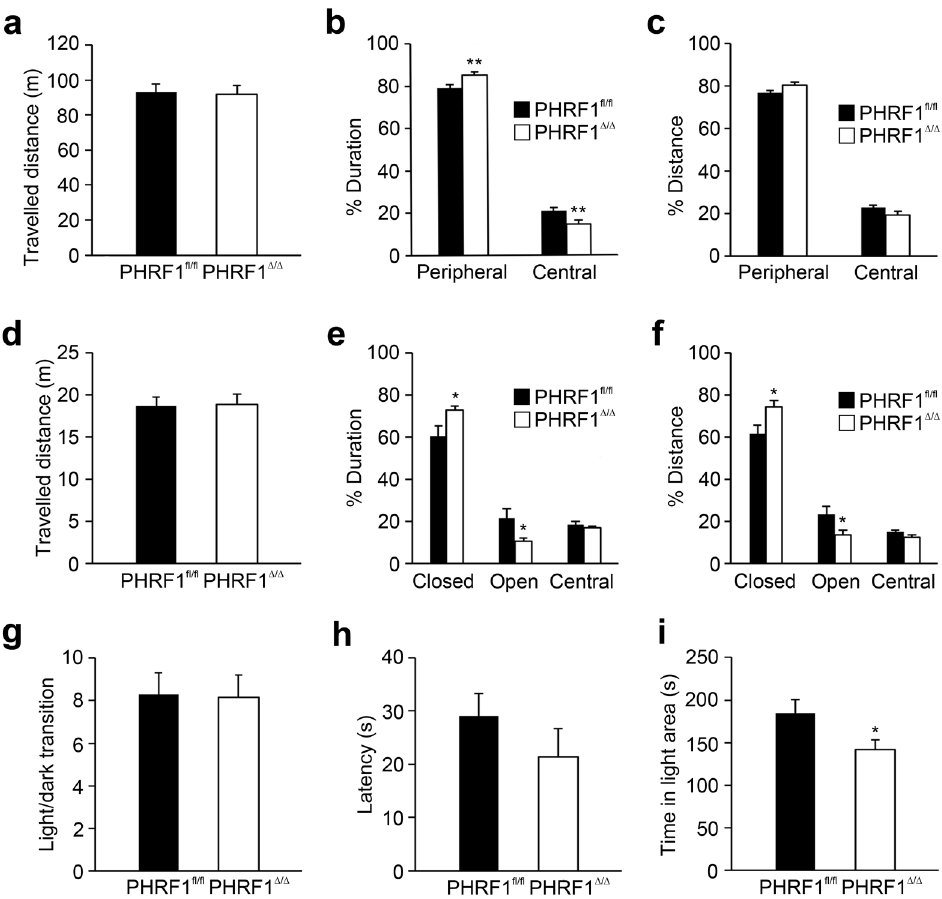
females; PHRF1 Δ/Δ n = 13, 10 males, 3 females) ( d – f ) Elevated-plus maze test. The travelled distance and